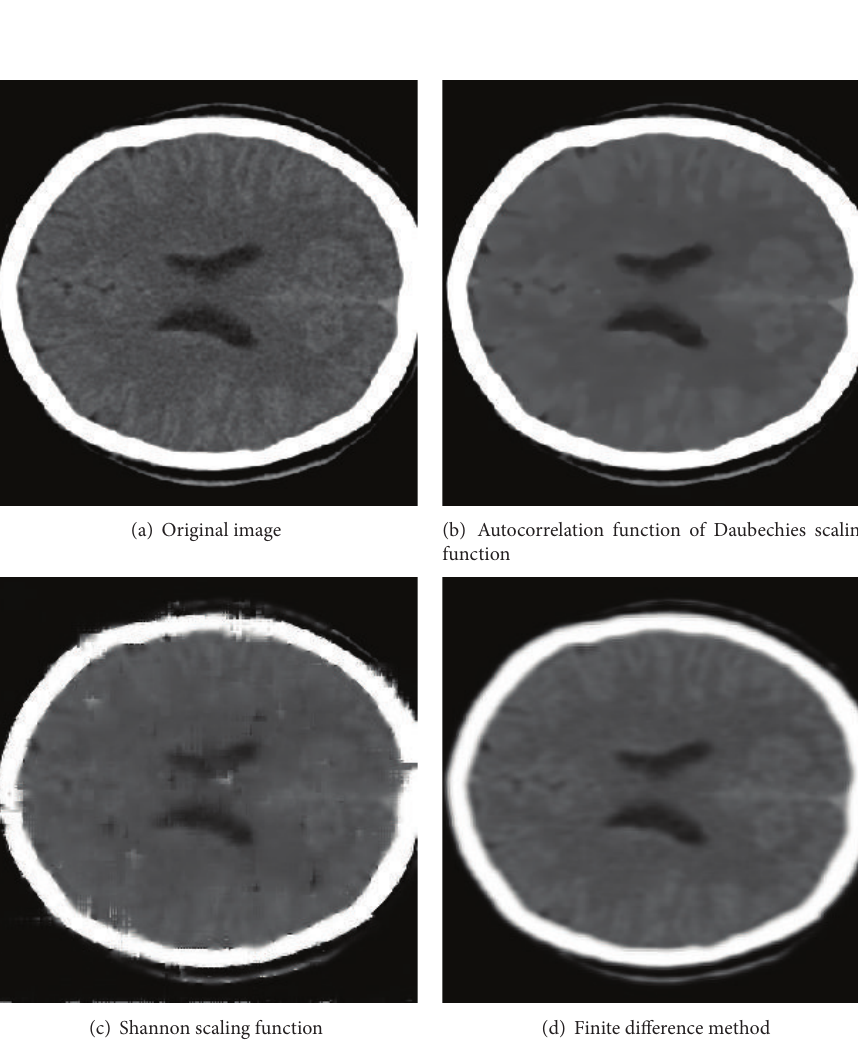
Figure 2: Comparison between different numerical methods for image denoising (time step 𝜏 = 0.00001 , terminal time 𝑡 = 0.00005